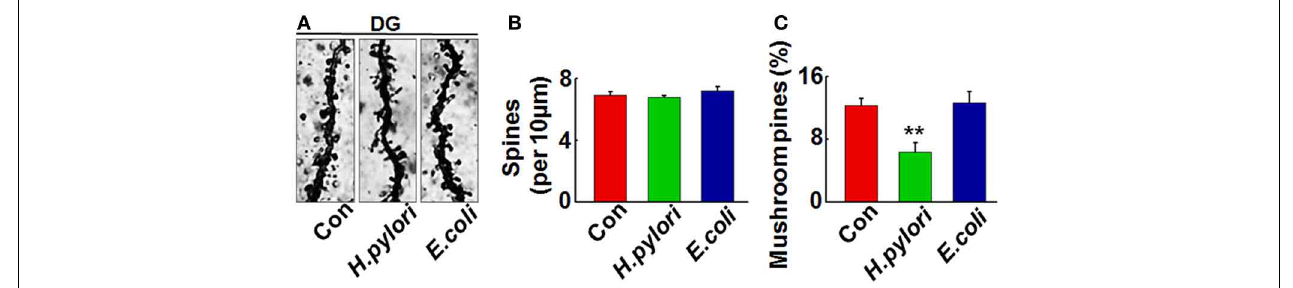
FIGURE 4 | Intraperitoneal injection of H. pylori filtrate impairs the dendritic spine maturation in rat hippocampal dentate gyrus. SD rats were intraperitoneally injected with H. pylori filtrate, E.coli filtrate or DMEM/Opti-MEM medium (280 μ l/rat/day) for 7 days as described in Figure 1A . Three rats were then anesthetized and fixed by transcardial perfusion, and brain slices of the rats were stained by Golgi staining. (A) The